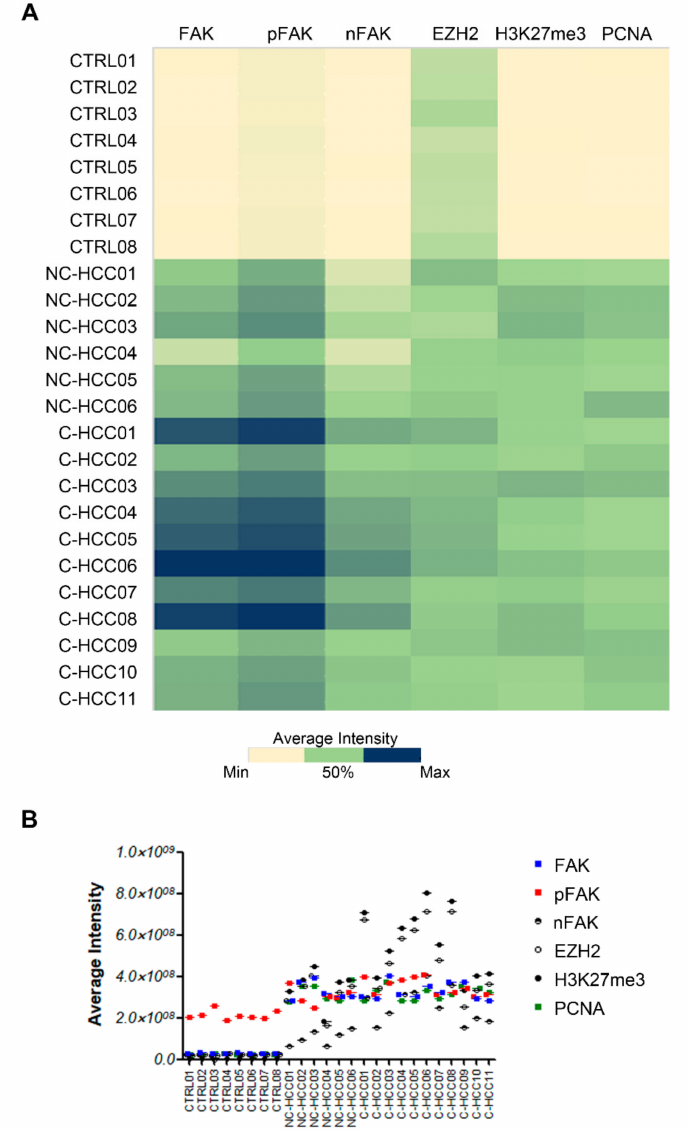
Figure 5. Correlation analysis between FAK, EZH2, H3K27me3, and PCNA in pediatric HCCs. Heatmap representation ( A ) and semiquantitative data ( B ) of the average fluorescence intensity for FAK, pFAK, nFAK, EZH2, H3K27me3, and PCNA in 8 healthy livers and 17 pediatric